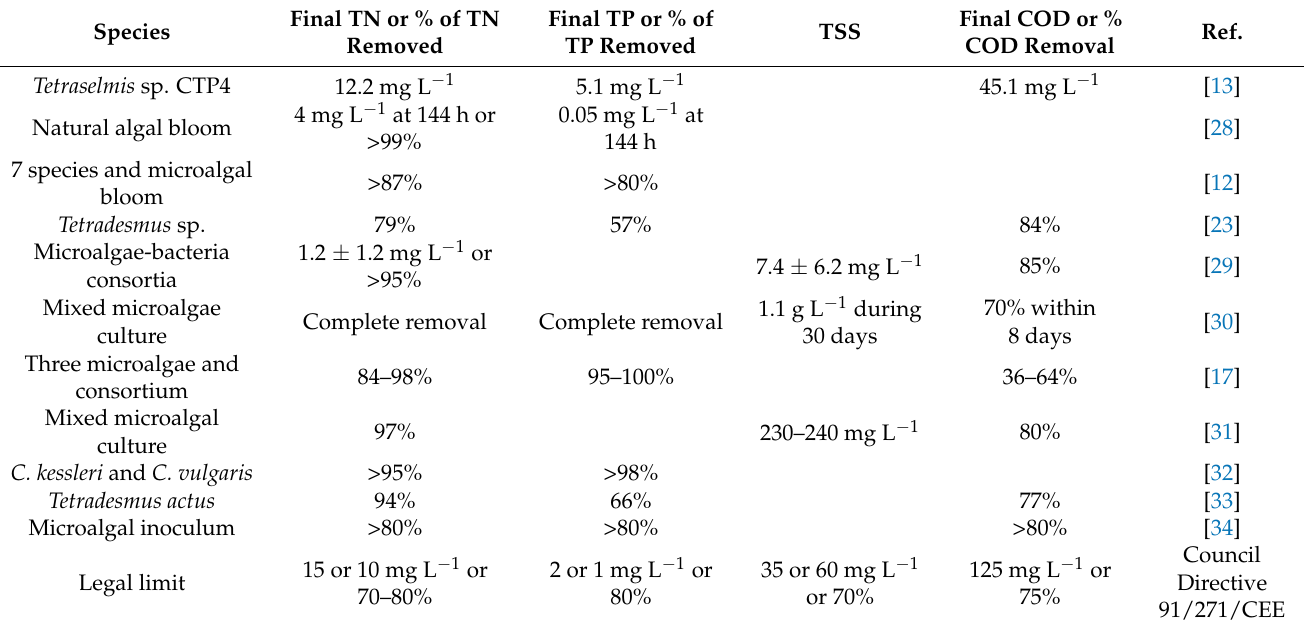
Table 1. Nutrient removal efficiencies from urban wastewater using